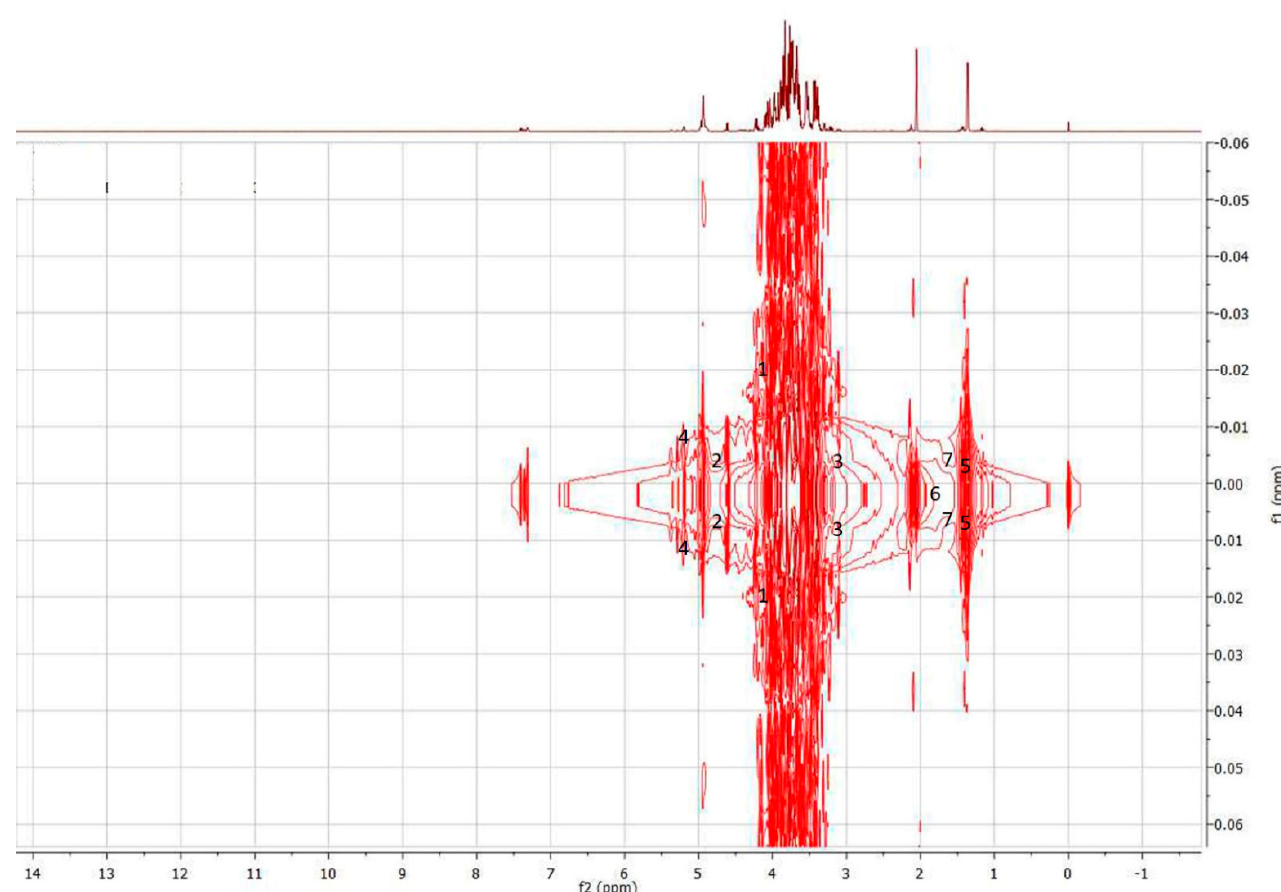
Figure 4. 1 H- 1 H J -resolved spectrum of T. apicalis honey in the region of 0.3–10.0 ppm. 1 , D -Fructofuranose; 2 , β - D -Glucose; 3 , D -Xylose; 4 , α - D -Glucose; 5 , L -Lactic acid; 6 , Acetic acid; 7 , L -Alanine .